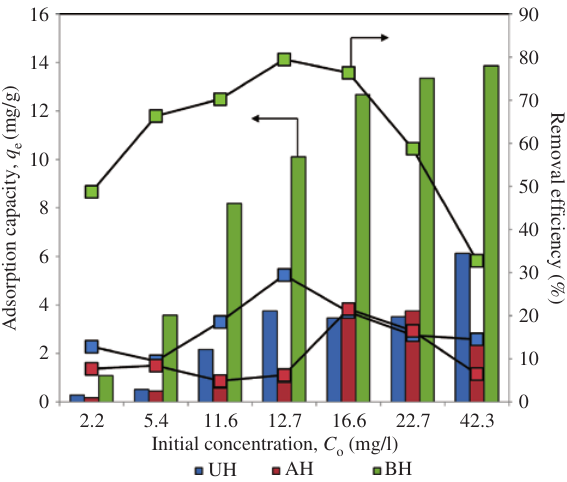
Figure 2: Effect of concentration on methylene blue removal by human hair adsorbents (bars: adsorption capacity; lines: removal efficiency).